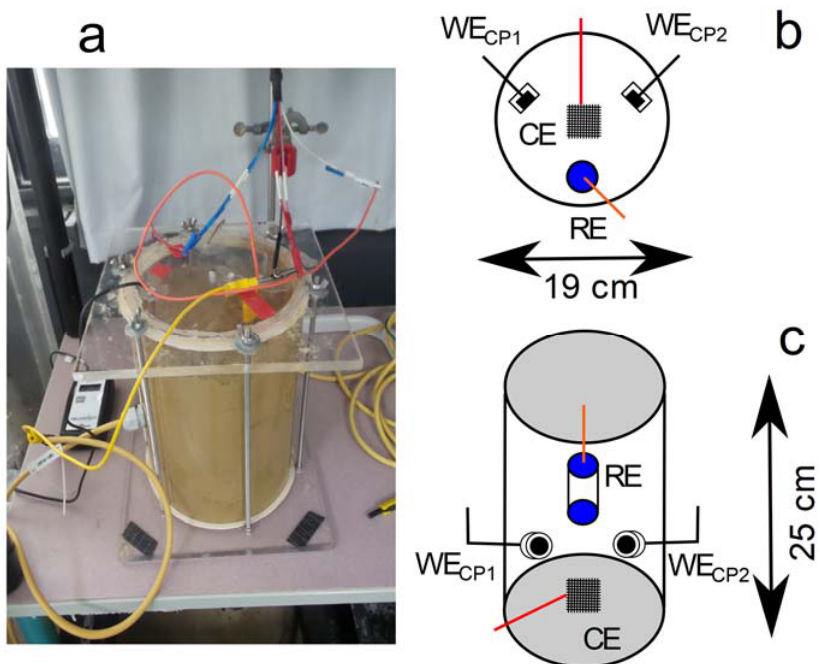
Figure 1. Representation of electrochemical cell for corrosion studies in soil: ( a ) picture of the cell, ( b ) schematic top view and ( c ) schematic side view. CE = counter electrode, RE = reference electrode, WE CP1 = working electrode cathodic protection 1 (steel coupon 1) and WE CP2 = working electrode cathodic protection 2 (steel coupon 2). The moisture sensor was omitted for clarity; the sensor reader is visible on the left of the picture.